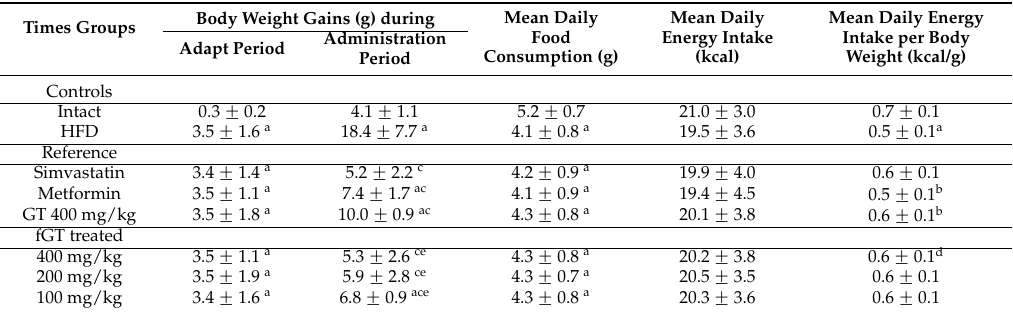
Table 2. Changes on body weight gains, mean daily food consumption and energy intake in NFD or HFD supplied mice.